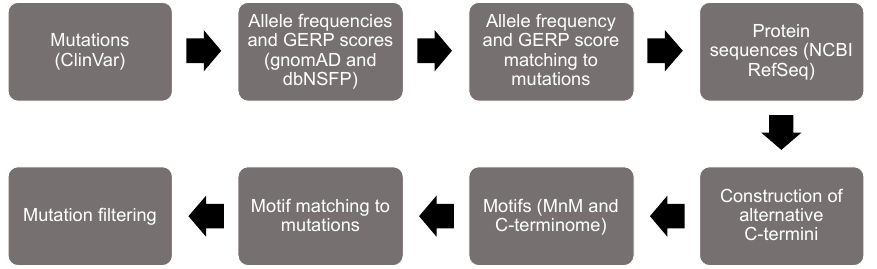
Figure 1. Flow chart of the bioinformatic analysis to identify minimotifs in the C-termini that are mutated in disease.